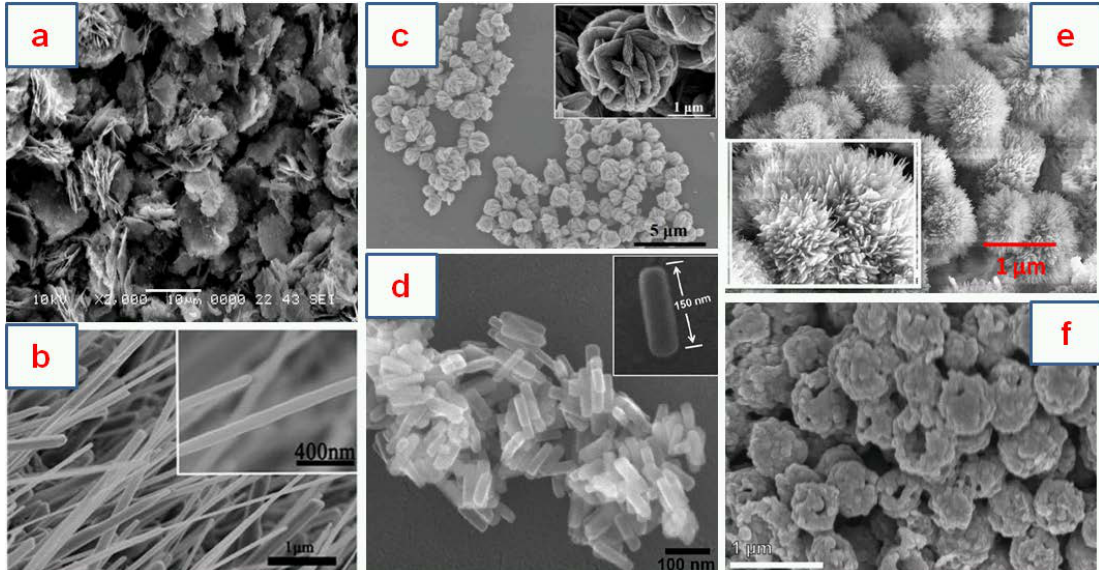
Figure 3. SEM photos of the copper oxides with different morphologies: ( a ) nanostructures (Reprinted